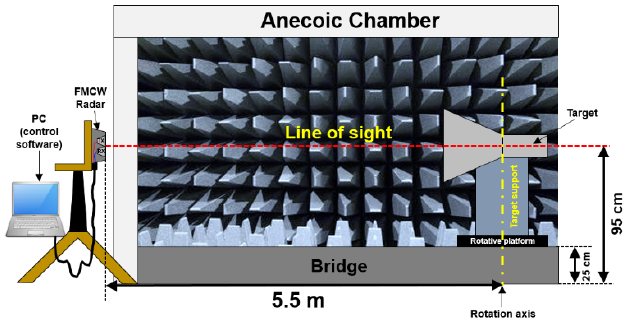
Figure 1. Schematic view of the measurement setup.